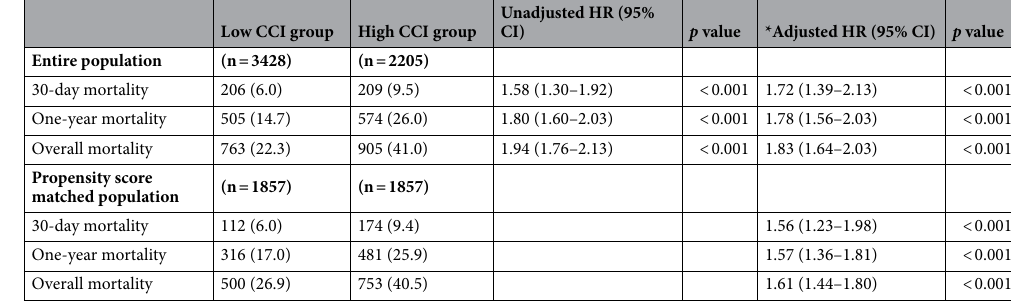
Table 2. Clinical outcomes of entire and propensity score matched population. *Covariates included age, sex, hypertension, alcohol, general anesthesia, emergency operation, use of RAAS inhibitor, statin, active cancer, and preoperative intensive care unit management.